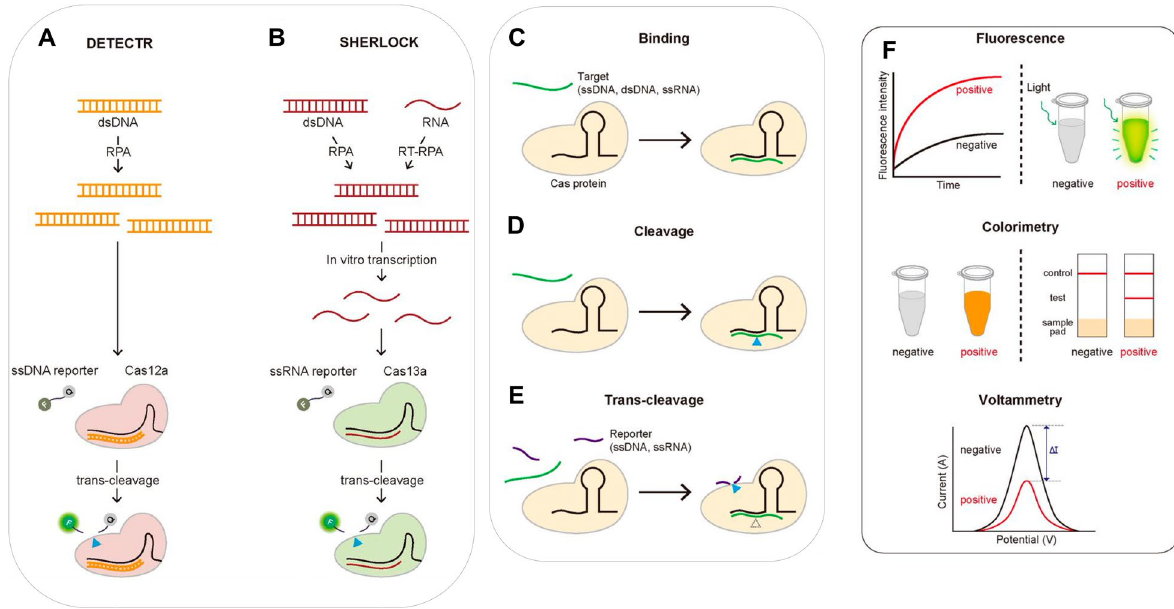
Fig. 2 CRISPR-based diagnostics. A , B Schematic of DETECTR and SHERLOCK assays; C Sequence-specific target binding. Catalytically inactive Cas proteins bind to the target gene that is complementary to gRNA. D Sequence-specific target cleavage. Cas proteins cleave the target gene, followed by the sequence-specific binding. E Target-specific trans-cleavage. Some Cas proteins such as Cas12a or Cas13a non-specifically cleave the ssDNA or ssRNA nearby upon binding to the target gene. F Three widely-used signal detection techniques: the fluorescence, colorimetric or electrochemical signal can be monitored to detect the existence of the analytes (Figure modified after Kim et al., Biomolecules 2021, 11(8); Copyright: CC BY